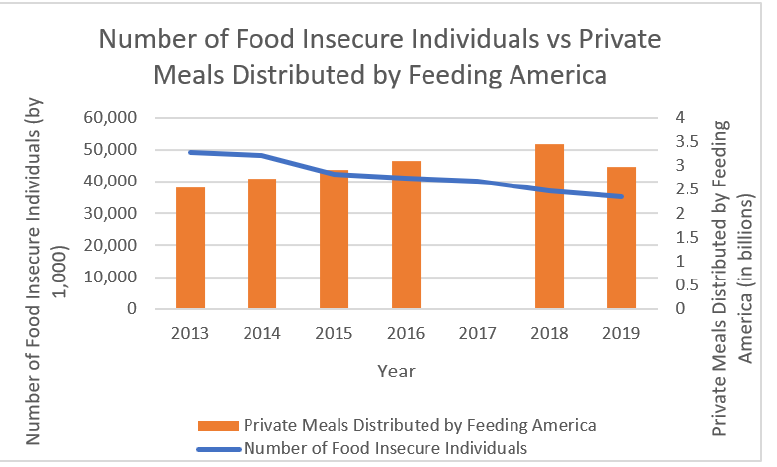
Figure 2. Number of food-insecure Americans compared to private meals distributed by Feeding America, 2013–2019. Charitable food data were calculated by Hunger Free America from statistics in the annual reports of the national NGO, Feeding America [11–16], and household food insecurity data are from the USDA’s 2020 Household Food Security report [3], both of which are publicly available. Feeding America data for 2017 is too limited to make an accurate